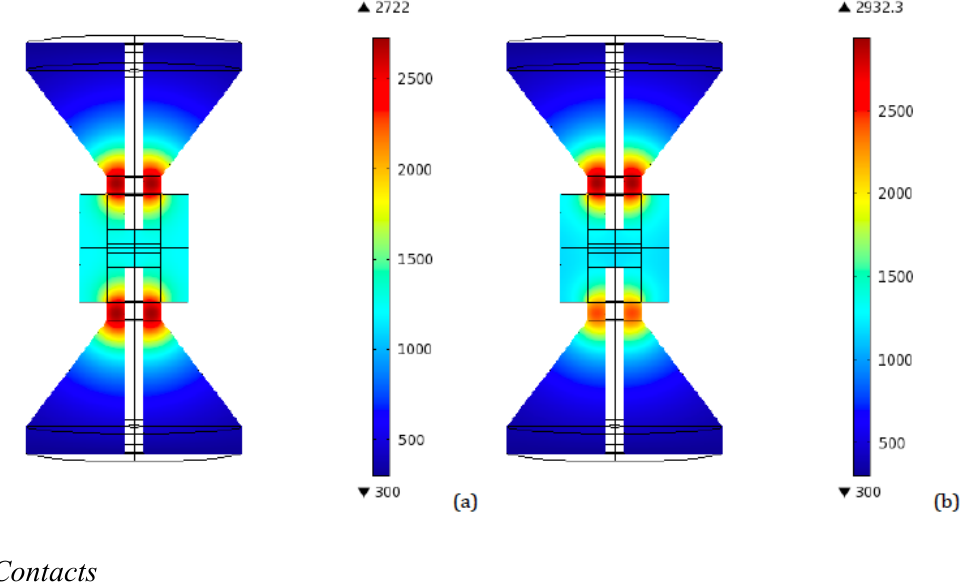
Figure 4. Conventional SPS 40 mm tooling—Peak temperatures (K) distribution for ( a ) Ideal contact; ( b ) Resistive